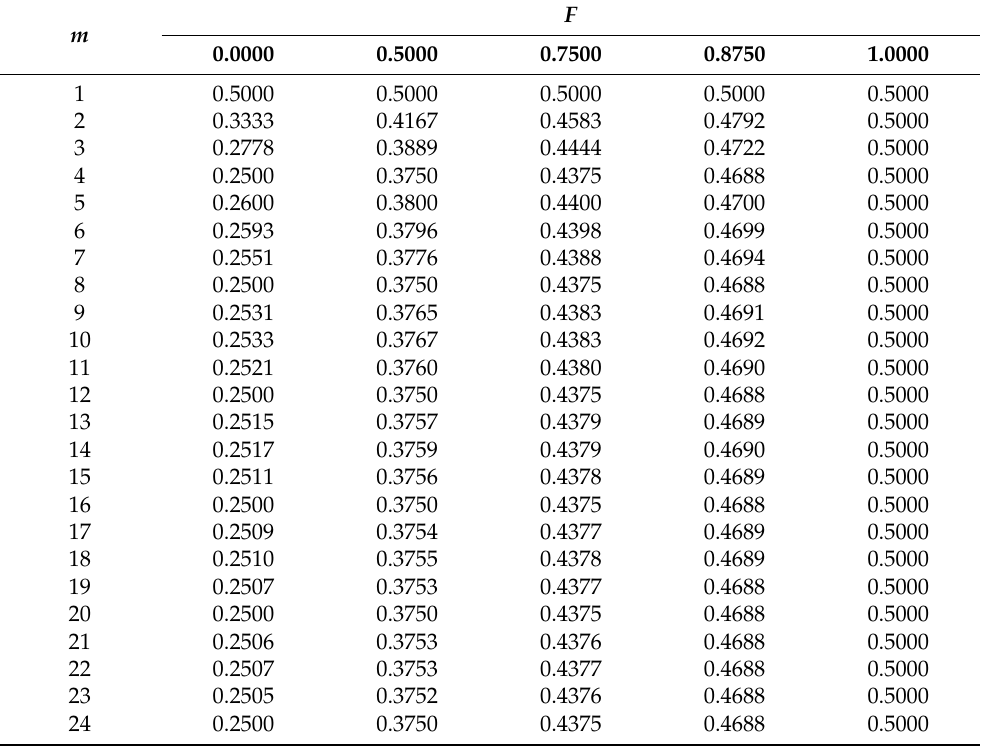
Table 2. Inbreeding coefficients of the progenies produced by random mating of the m representatives of a single cross. The parent lines of the cross are unrelated and their inbreeding coefficient is equal to F . The calculation was performed with the formula of Equation (2) for FSyn SC with s = 1.